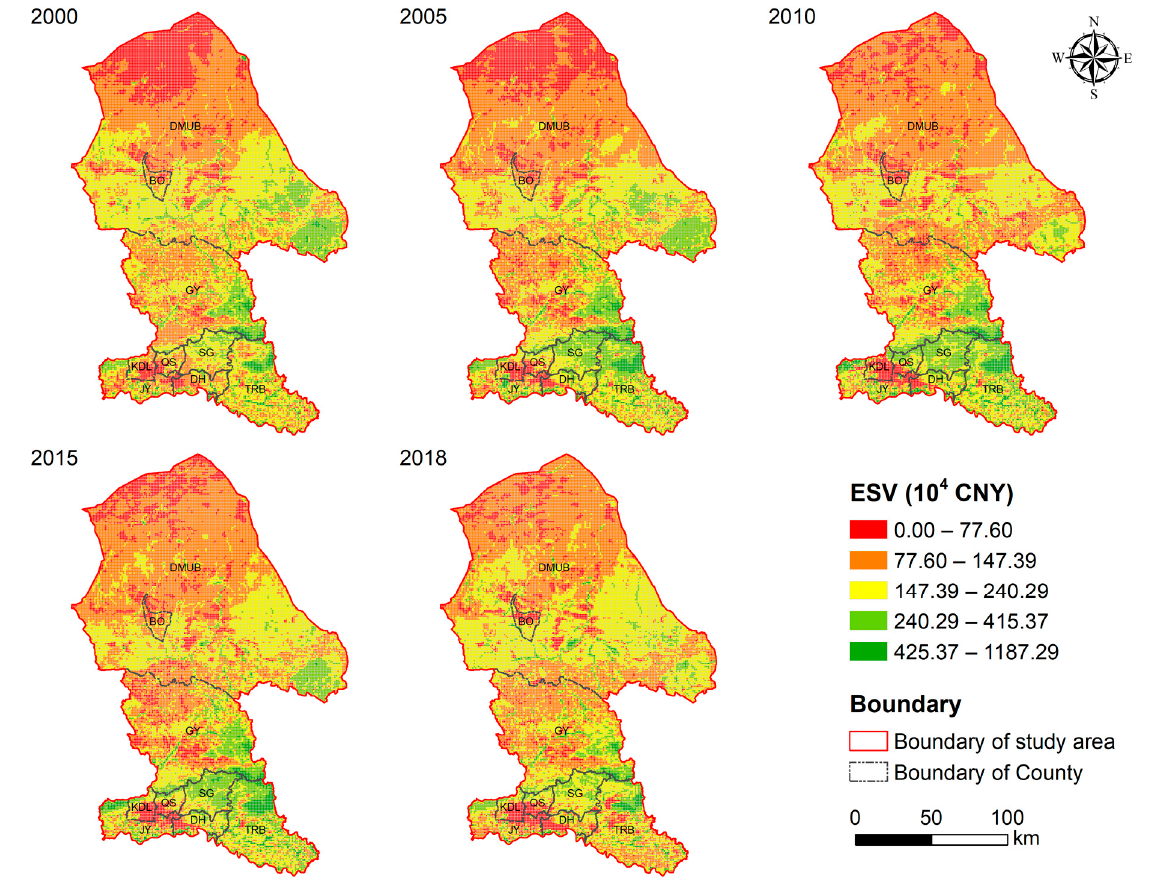
Figure 5. Spatial pattern of ESV in Baotou from 2000 to 2018.